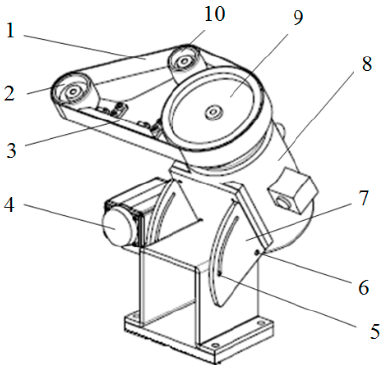
Figure 10. Axonometric view of the belt grinding mechanism. 1—sanding belts; 2,9,10—sanding belt support wheels; 3—sanding belt support frame; 4—electric motors; 5—guide pins; 6—spindle; 7—support frame for electric motor actuators; 8—electric motor actuators.